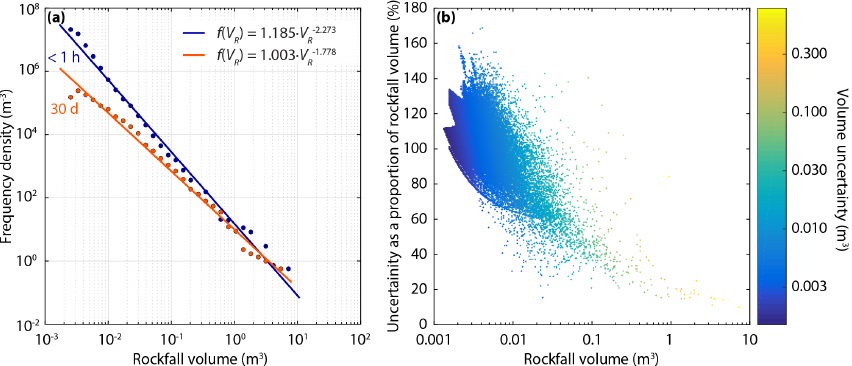
Figure 12. (a) Magnitude–frequency distribution for rockfall inventories acquired at varying T int showing that a higher proportion of small events is established by monitoring at high frequencies. Rockfalls used range from 5 March to 30 November 2015 to enable direct comparison between T int <1h and nine T int = 30 days change detections. (b) Rockfall volumes from <1h rockfall inventory. Percentage volume error is estimated using the LoD, number of internal pixels, and number of edge pixels. Frequency densities (kernel density estimates) are appended to each axis, showing that rockfall volumes <0.01m 3 account for the greatest proportion of measured rockfalls (modal volume = 0.0081m 3 ). As a result, errors range from ∼ 60 to ∼ 140% for most rockfalls (modal error percentage = 109%). Cumulative volume estimations using rockfalls of this size may vary by at least the actual